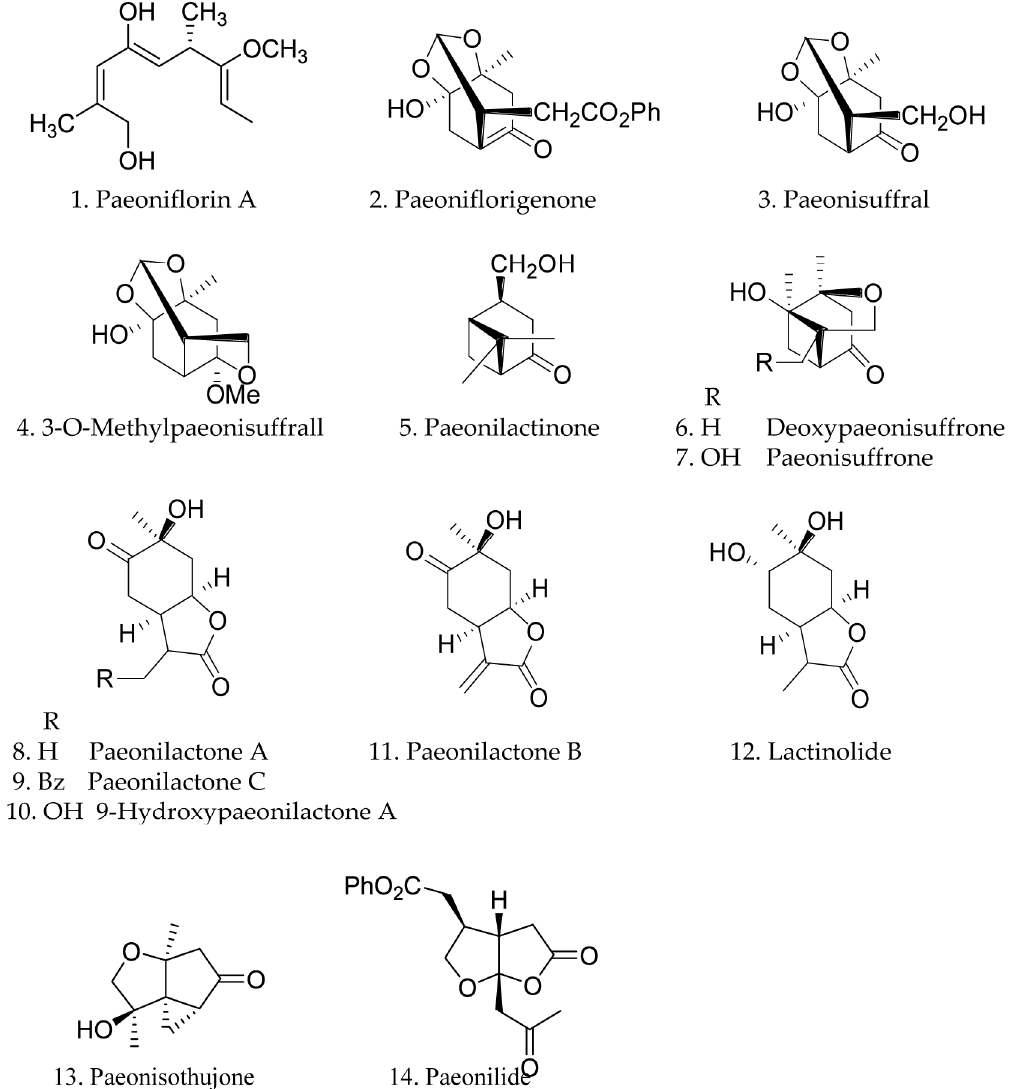
Figure 2. Chemical structures of monoterpene.